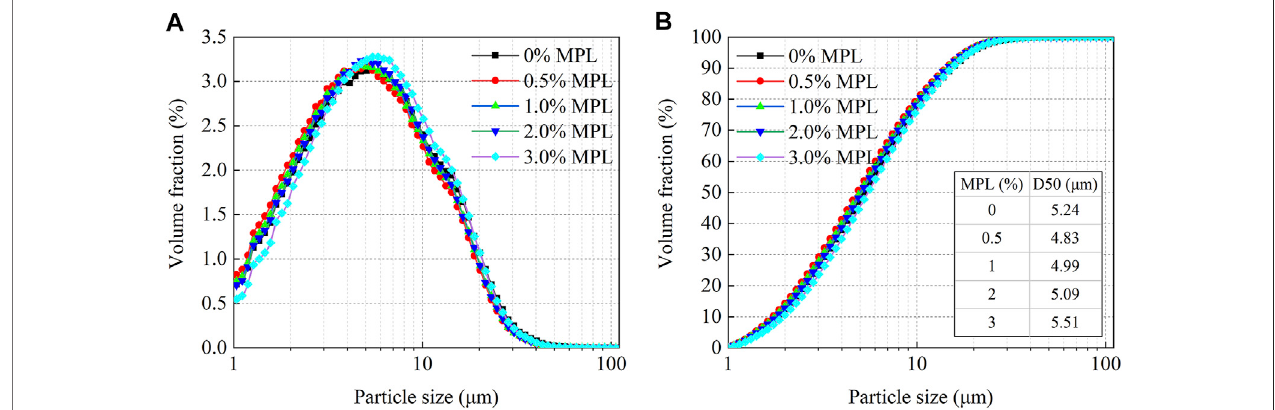
FIGURE9| The fl uid lossvolume vs . timecurvesforMPL oildispersionsformicroporousmembranes withdifferentpore sizes: (A) 0.1 μ m, (B) 0.3 μ m, (C) 0.5 μ m, and (D) 1.0 μ m.